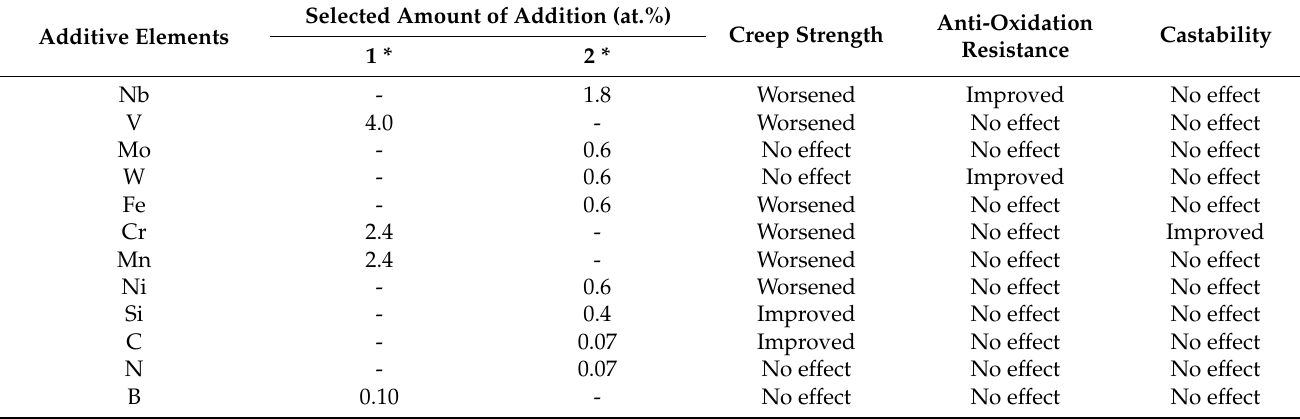
Table 3. Effect of additive elements, with added amounts, compared to binary alloys considering the impact resistance in the as-cast state. Selected Amount of Addition